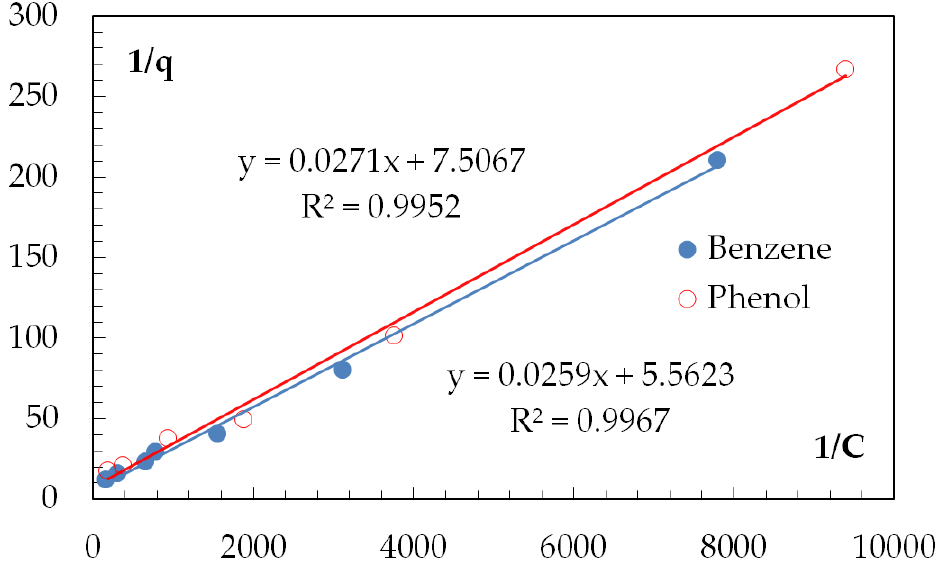
Figure 16. Linear form of the phenol and benzene sorption isotherm on organic material.